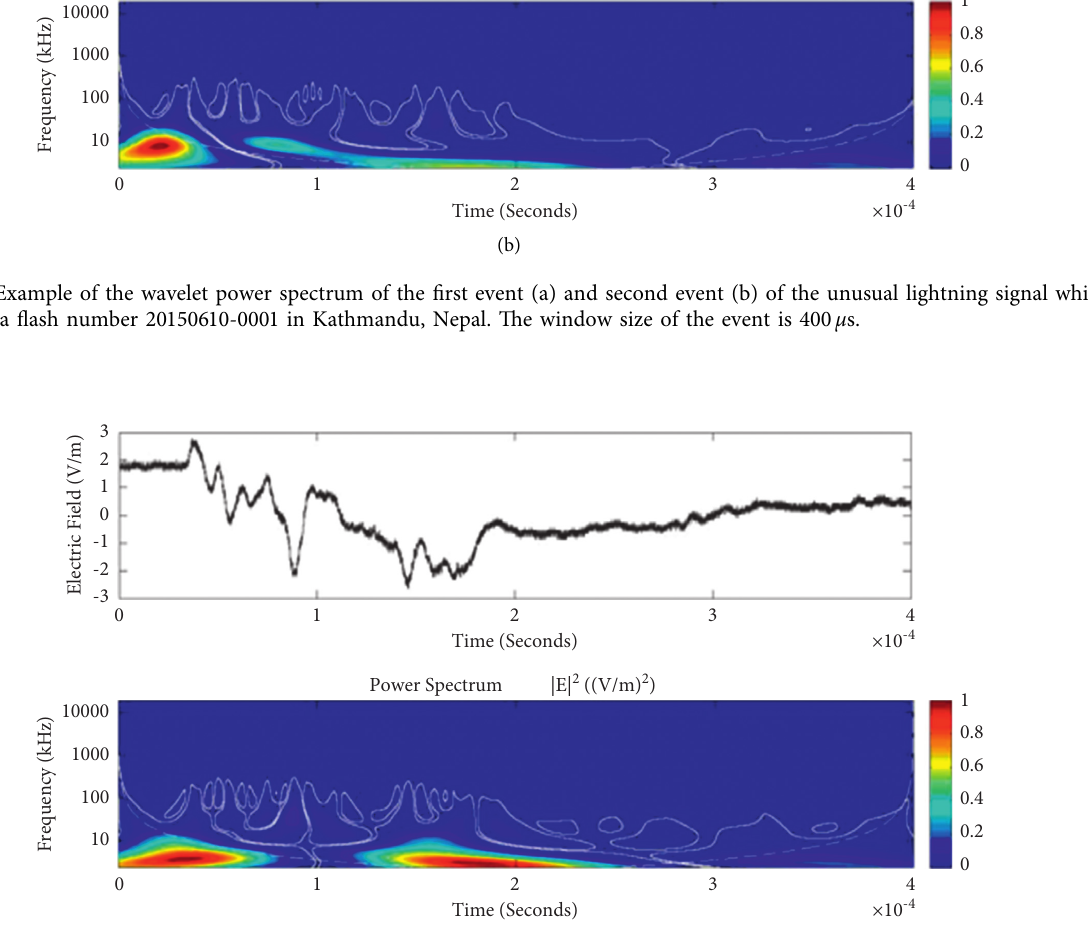
Figure 15: Example of the wavelet power spectrum of the event of unusual lightning signal which is recorded as a flash number 20150611- 0003 in Kathmandu, Nepal. The window size of the event is 400 μ s. Table 1: Statistics of the wavelet power spectrum of the unique